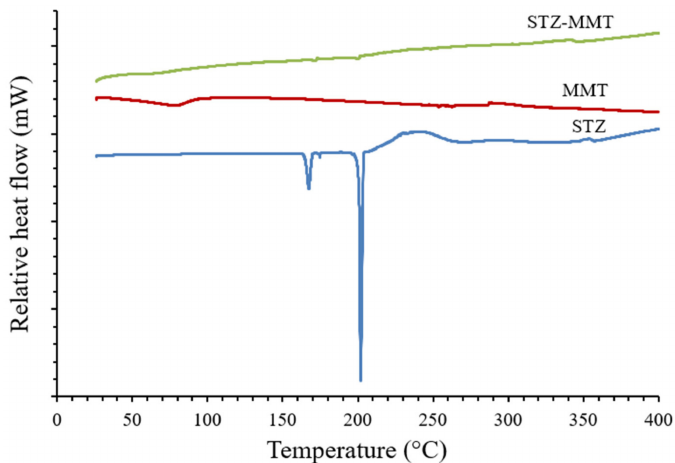
Figure 4. DSC profiles of the studied